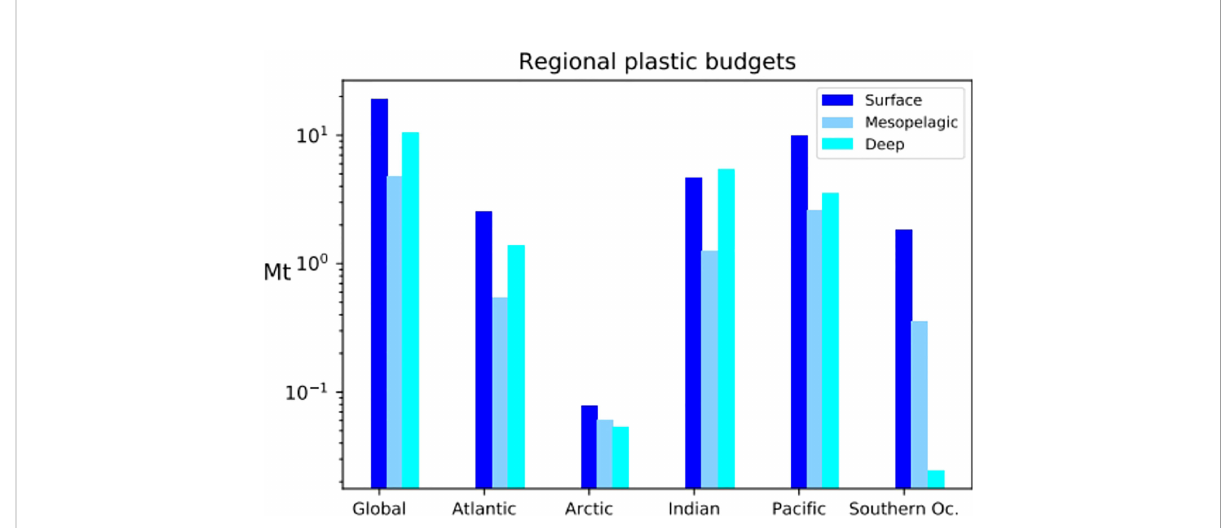
FIGURE 3 Plot of the MP budget (in Mt) in each ocean on the surface (0 – 100 m), mesopelagic (100 – 1,000 m), and deep (>1,000 m)